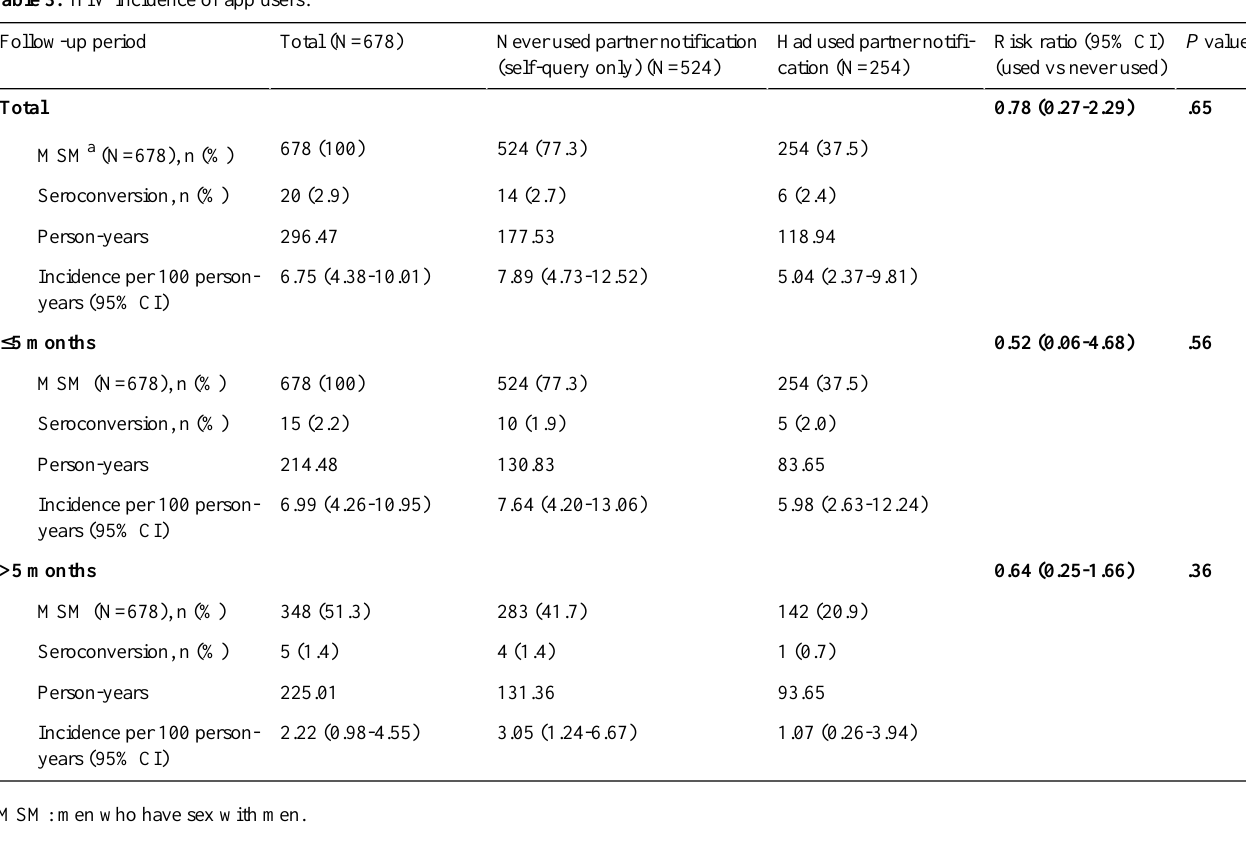
Table 3. HIV incidence of app users.